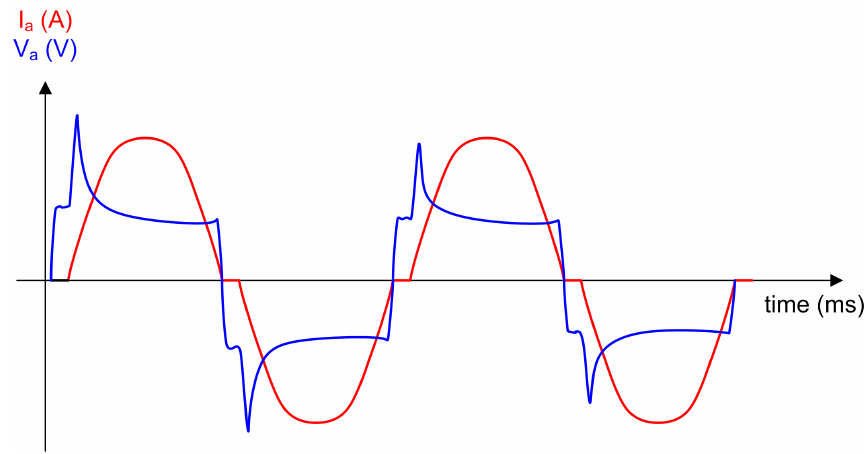
Figure 2. Typical voltage (blue) and current (red) AC waveforms (not to